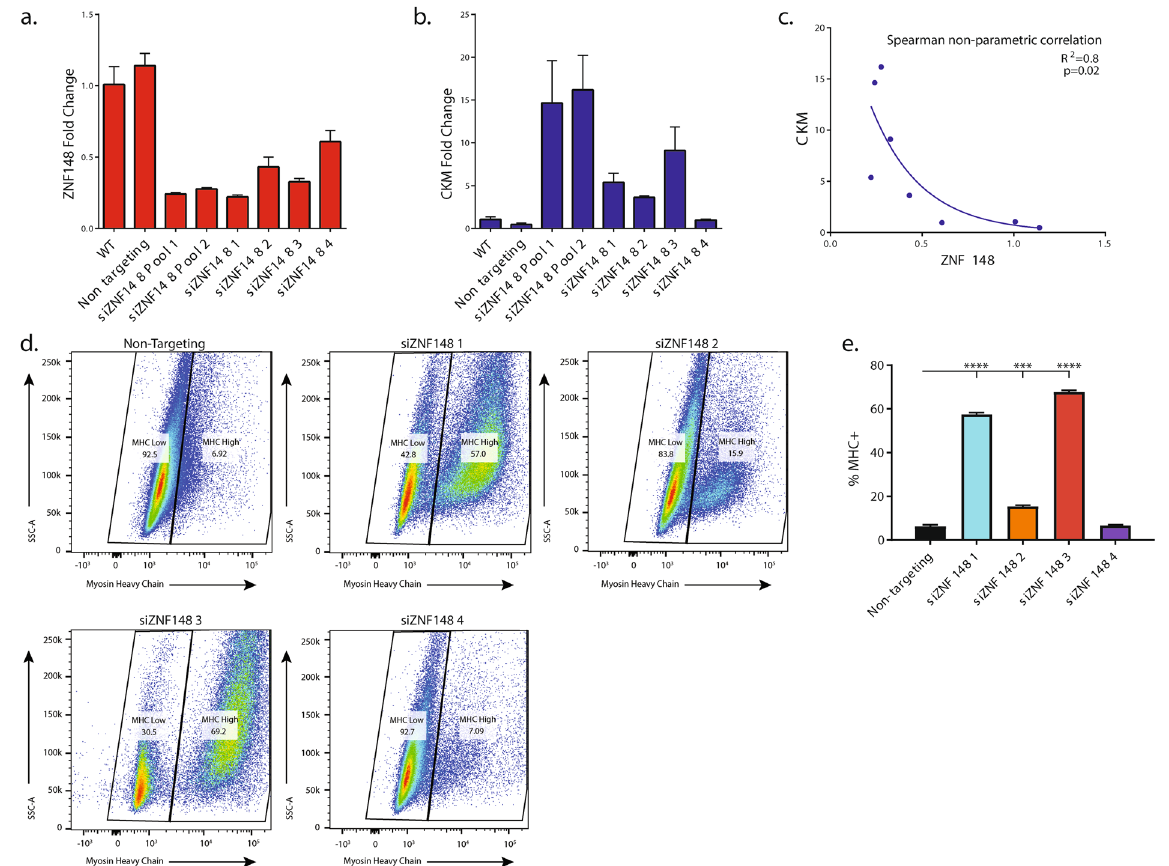
Figure 2. ZNF148 is a negative regulator of human myogenesis. ( a ) ZNF148 and ( b ) muscle creatine kinase ( CKM ) mRNA expression in LHCN-M2 cells grown for 3 days in differentiation media. Treatment groups include untreated (WT), nontargeting siRNA, two pools containing four siRNAs each, and four individual siRNA sequences. ( c ) Scatterplot and nonlinear fit of CKM and ZNF148 expression levels. Statistics were calculated with a nonparametric Spearman rank-order correlation and a two-tailed P value. ( d ) Flow cytometric analysis comparing the level of myosin heavy chain (MHC) expression in LHCN-M2 cells treated with nontargeting or four individual ZNF148 siRNAs. Representative figures are shown, n = 3 independent experiments with 250,000 events collected per experiment. SSC-A stands for side scattered light area. ( e ) Bar graph representing the percentage of cells with high MHC expression levels. Data were analyzed by one-way ANOVA. *** P < 0.01, **** P <